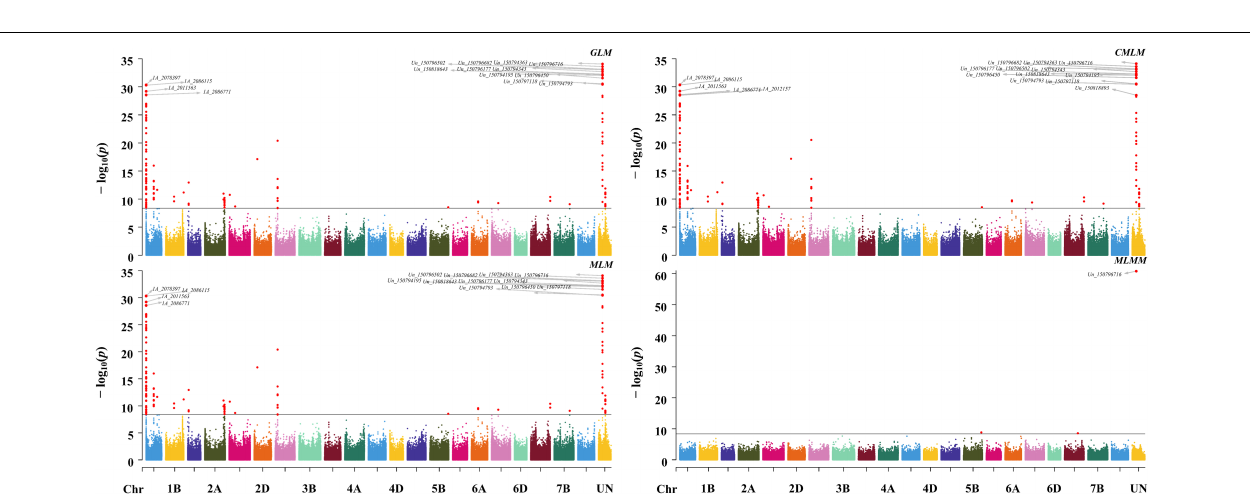
Frontiers in Plant Science |